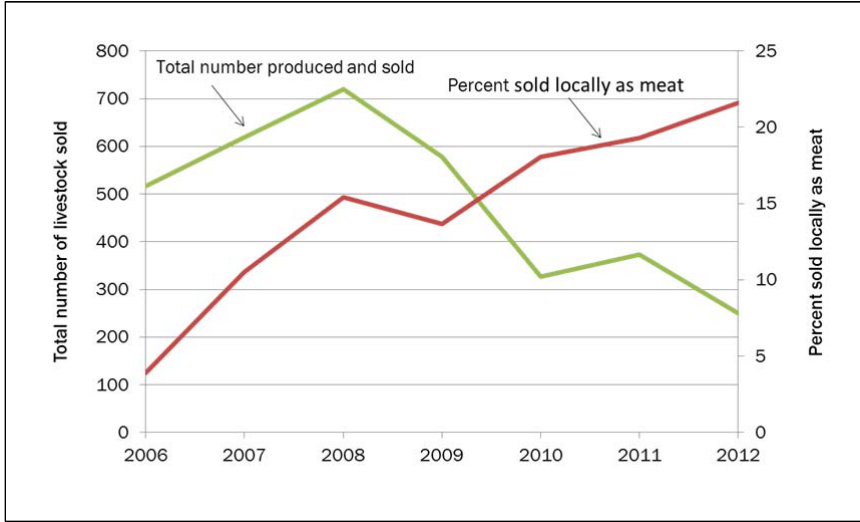
Figure 6. Number of Livestock (Beef Cattle, Hogs, Sheep, and Goats) Produced and Sold and the Percent Sold Locally as Meat,